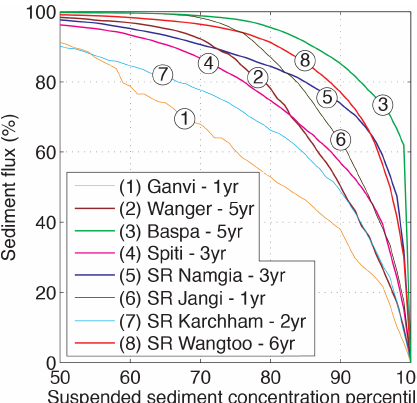
Fig. 5. Percentage of peak SSC events on total suspended sediment flux. Length of the data set is given in the legend. The legend shows tributary stations (1–4) from south to north and the Sutlej River (SR) main stem stations (5–8) in downstream direction (cf. Fig.